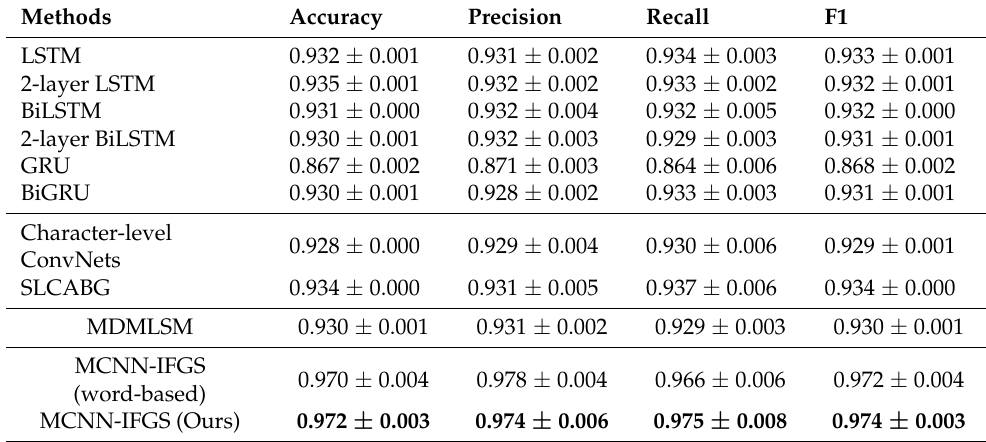
Table 3. The results of different methods on Chinese review dataset. Here, each method was run five times. The value before “ ± ” was the mean value, followed by the standard